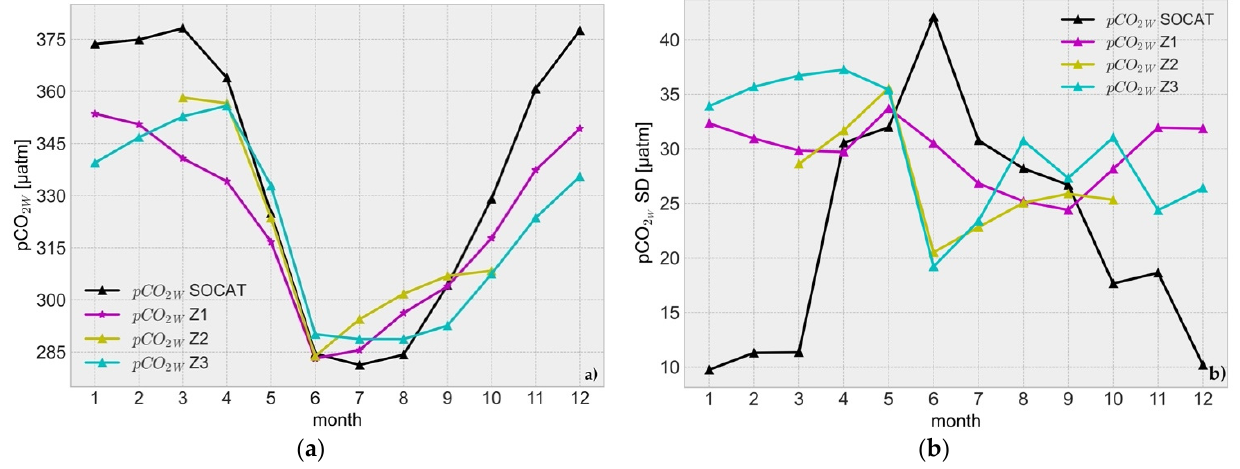
Figure 3. ( a ) Climatological monthly average of observed pCO 2W (black) and estimated pCO 2W over grid boxes for which observed pCO 2W values were available; ( b ) monthly average of the σ between observed (black) and estimated pCO 2W .